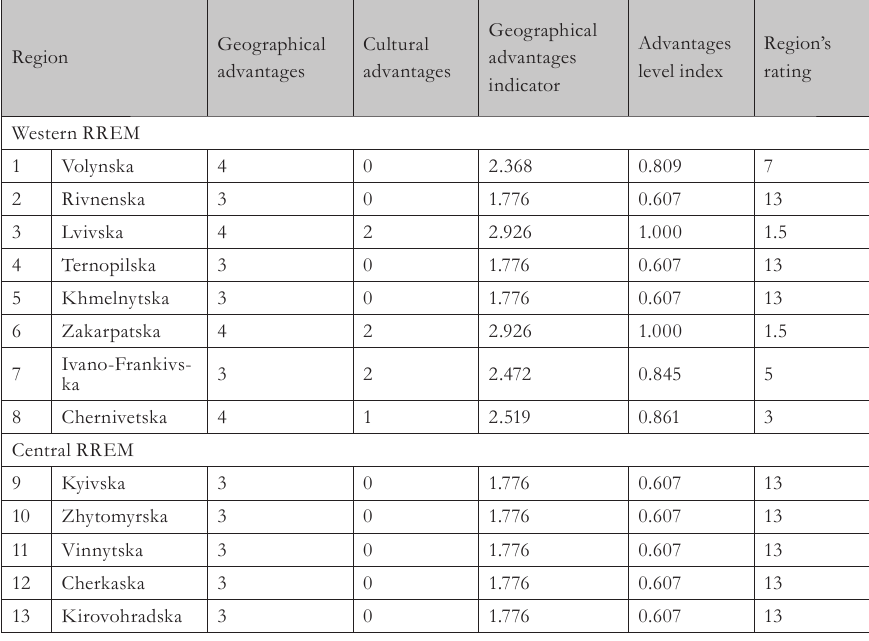
Tab. 7 – Cultural and geographical advantages of Ukraine regions in terms of their division into RREM, on January 1, 2017, (excluding the temporarily occupied territory of the Autono- mous Republic of Crimea, the city of Sevastopol and parts of the zone of the anti-terrorist operation in Donetska and Luhanska regions). Source: own research Geographical Advantages Region’s Geographical Cultural Region advantages level index advantages advantages indicator